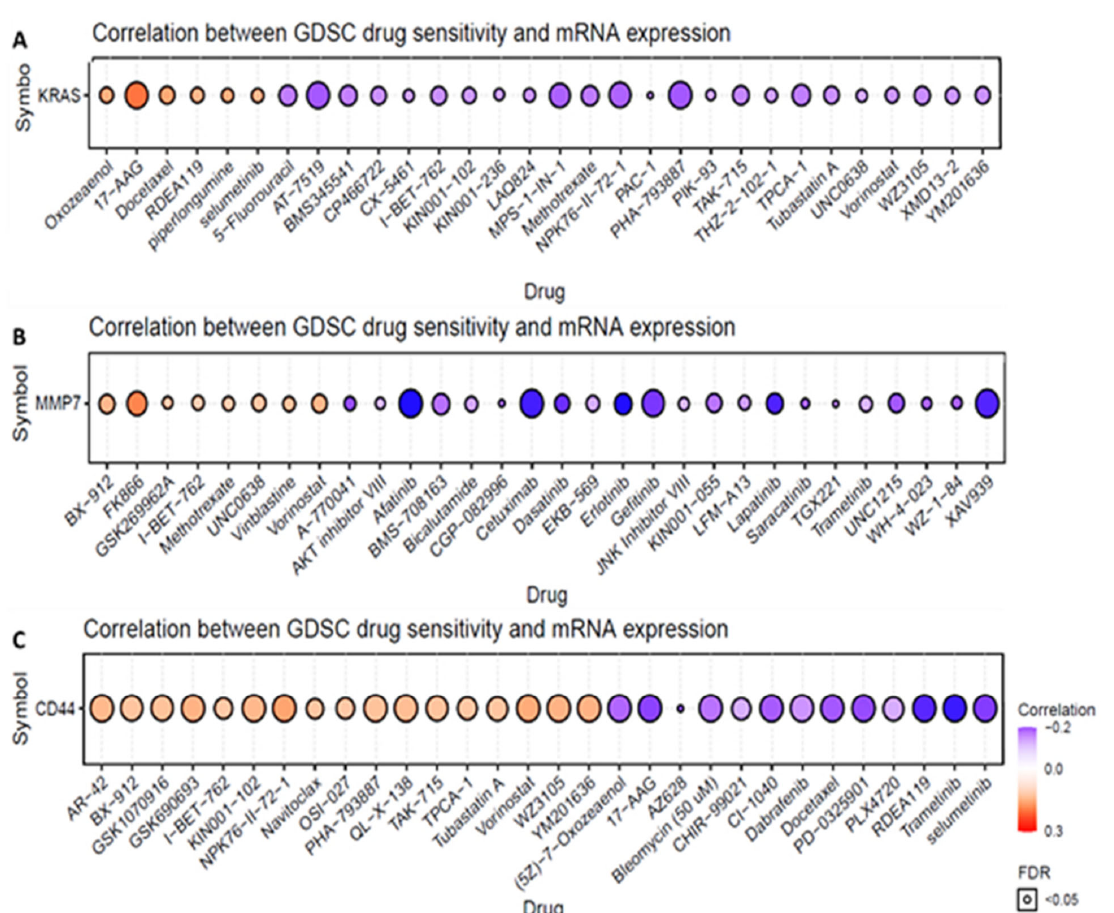
Figure 4. Drug sensitivity of the KRAS/MMP7/CD44 oncogenes from GSCA. ( A – C ) Correlations between genomics of drug sensitivity in cancer (GDSC) from FDA ‐ approved drugs. Positive Spearman correlation coefficients (orange circles) indi ‐ cate that increased gene expression levels were resistant to the drug, compared to negative correlations shown in blue, which indicate sensitivity to the